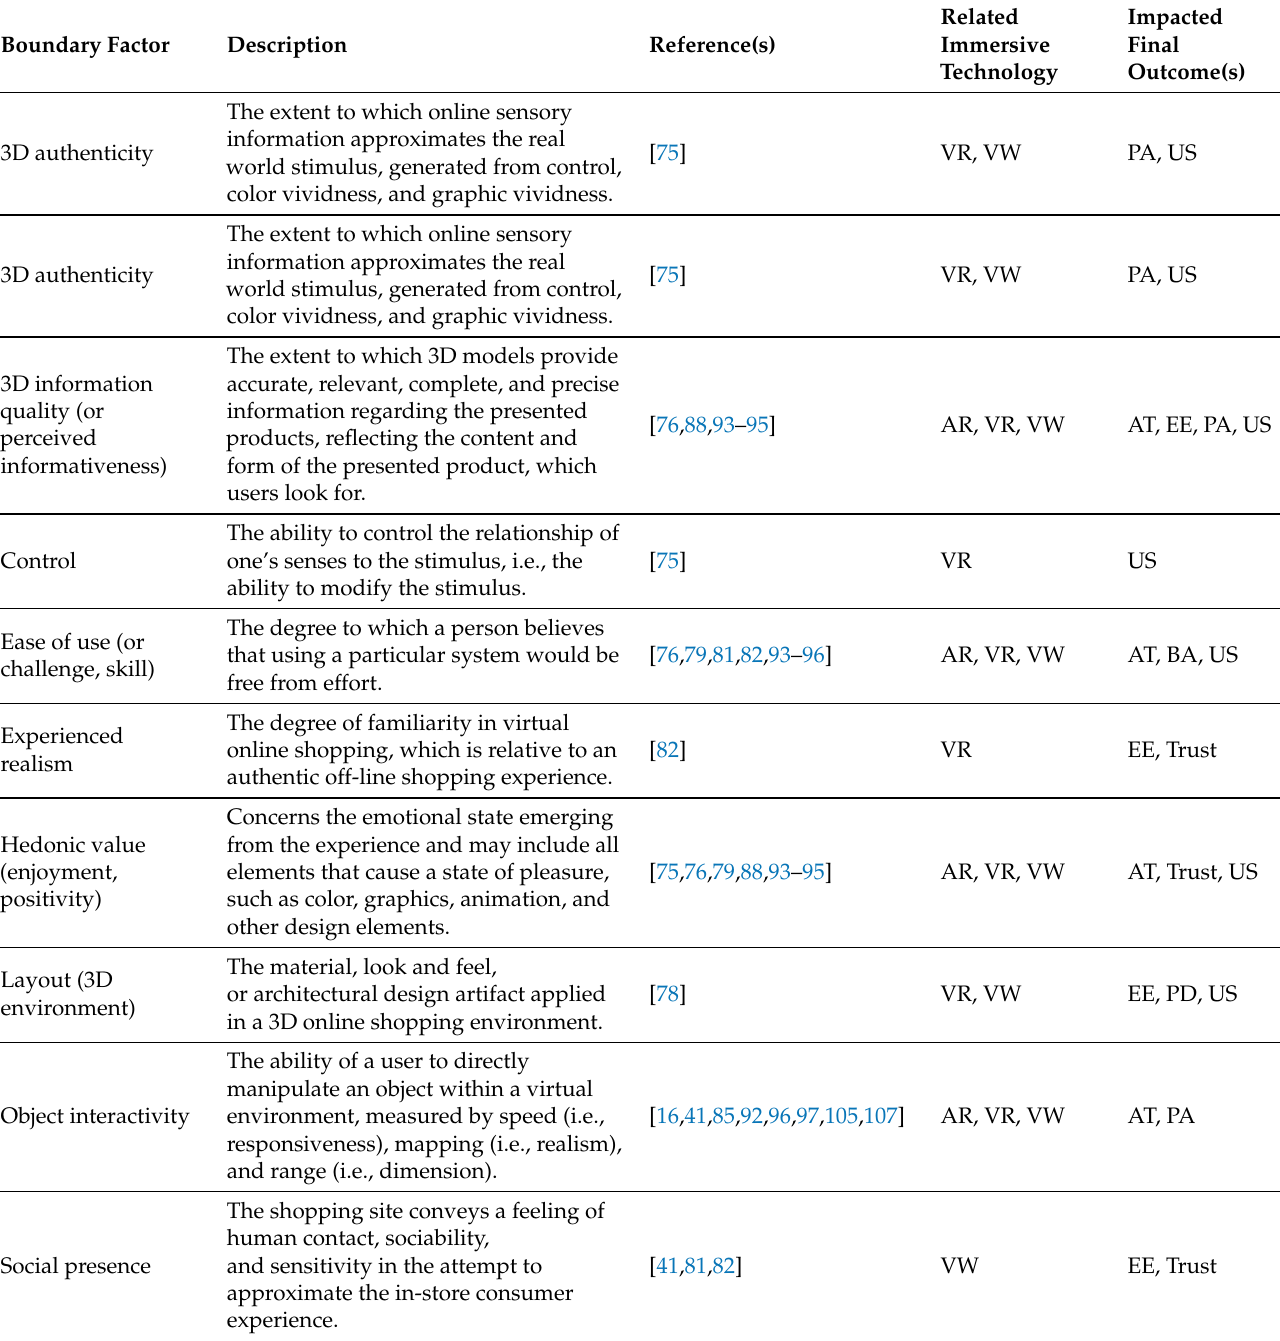
Table 7. List of boundary factors and corresponding included